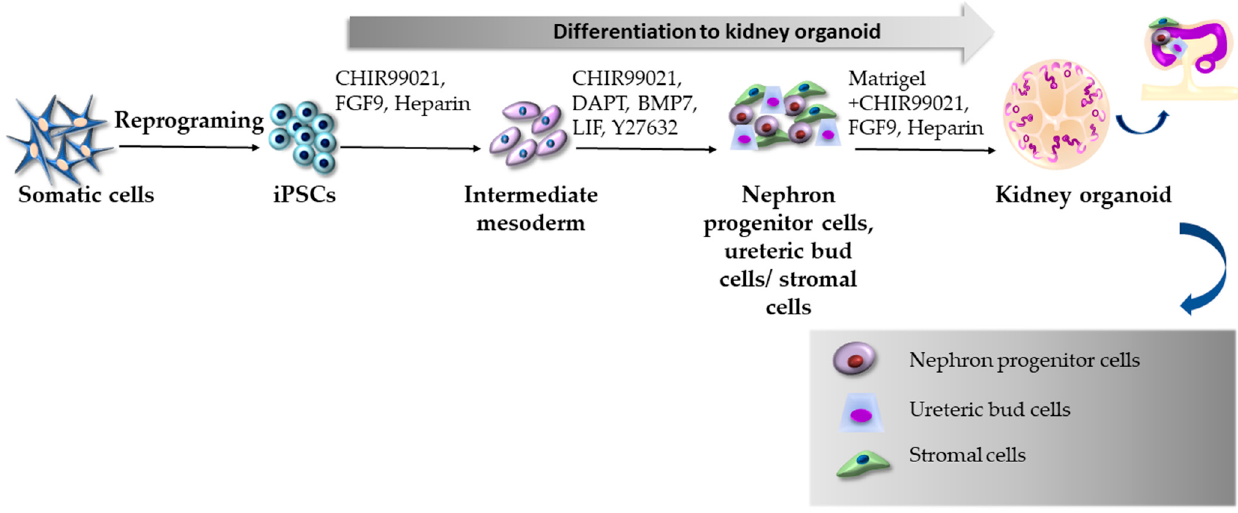
Figure 6. Generation of kidney organoids according to the protocol by Vanslambrouck et al.